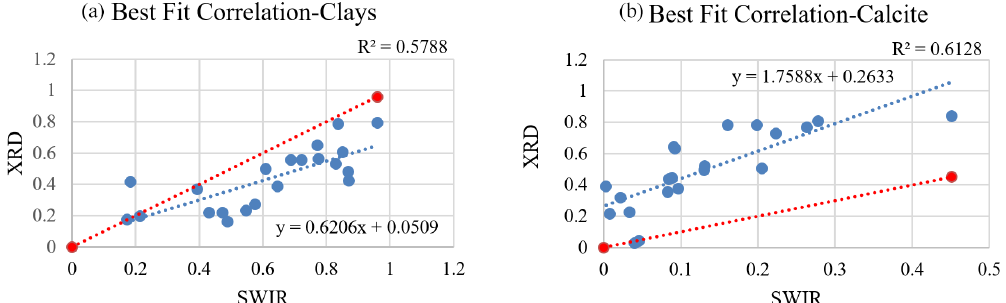
Figure 11. Plots display the difference between abundance values (in wt%) derived from XRD and SWIR. Data and the best fit line are in blue, and a 1 : 1 correspondence is shown in red. In (a) clay abundances obtained from SWIR demonstrate a relatively higher value, suggesting underestimation by the XRD. In (b) the SWIR-derived abundances strongly underestimate the amount of calcite compared to